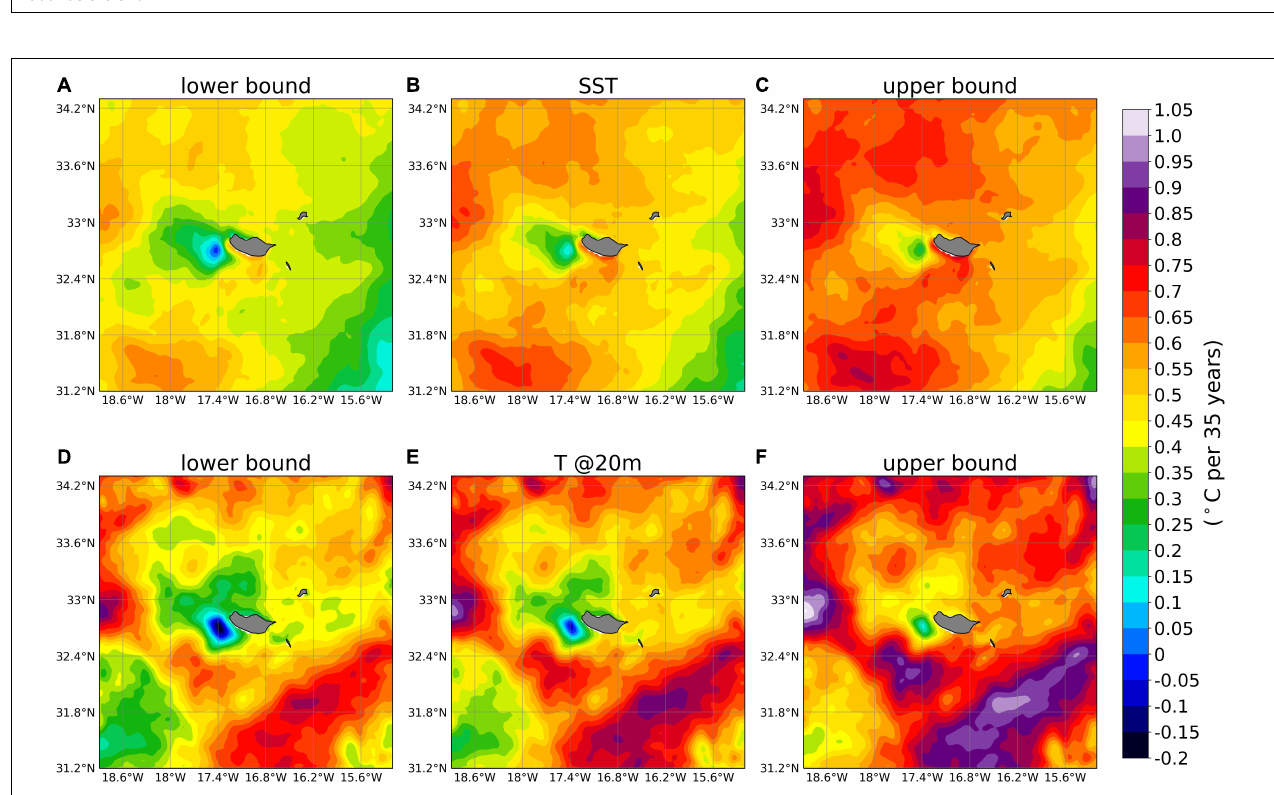
FIGURE 12 | Theil–Sen estimates of the summer (JJA) ocean temperature trend (1983–2017): surface (A) Lower bound, (B) central estimate, and (C) upper bound; 20 m depth (D) Lower bound, (E) central estimate, and (F) upper bound. Upper and lower bounds were estimated at the 95% confidence level.